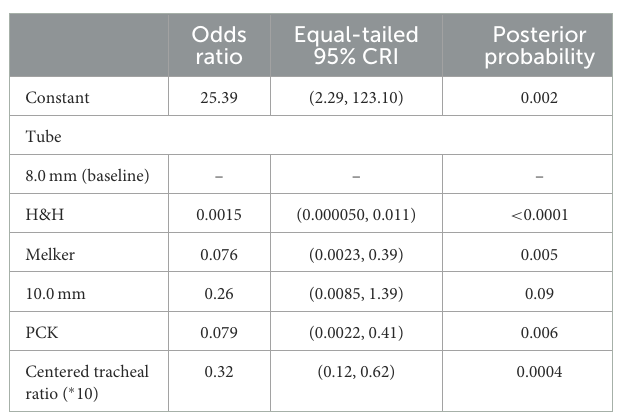
TABLE 2 Bayesian logistic regression model for estimating of odds ratio of successful airway sealing in ten cadaver dogs with different cricothyroid tubes